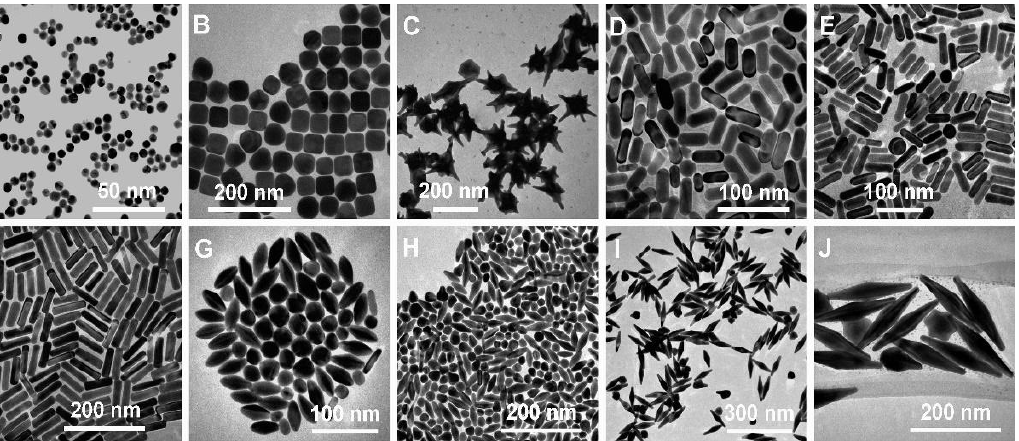
Figure 4. Transmission Electron Microscopy (TEM) images of different AuNPs of different sizes and shapes. ( A ) Nanospheres, ( B ) Nanocubes, ( C ) Nanobranches, ( D ) Nanorods, ( E ) Nanorods, ( F ) Nanorods, ( G ) Nanobipyramids, ( H ) Nanobipyramids, ( I ) Nanobipyramids, and ( J ) Nanobipyra- mids. Reproduced with permission from Chen et al. [86]. Copyright 2008, American Chemical